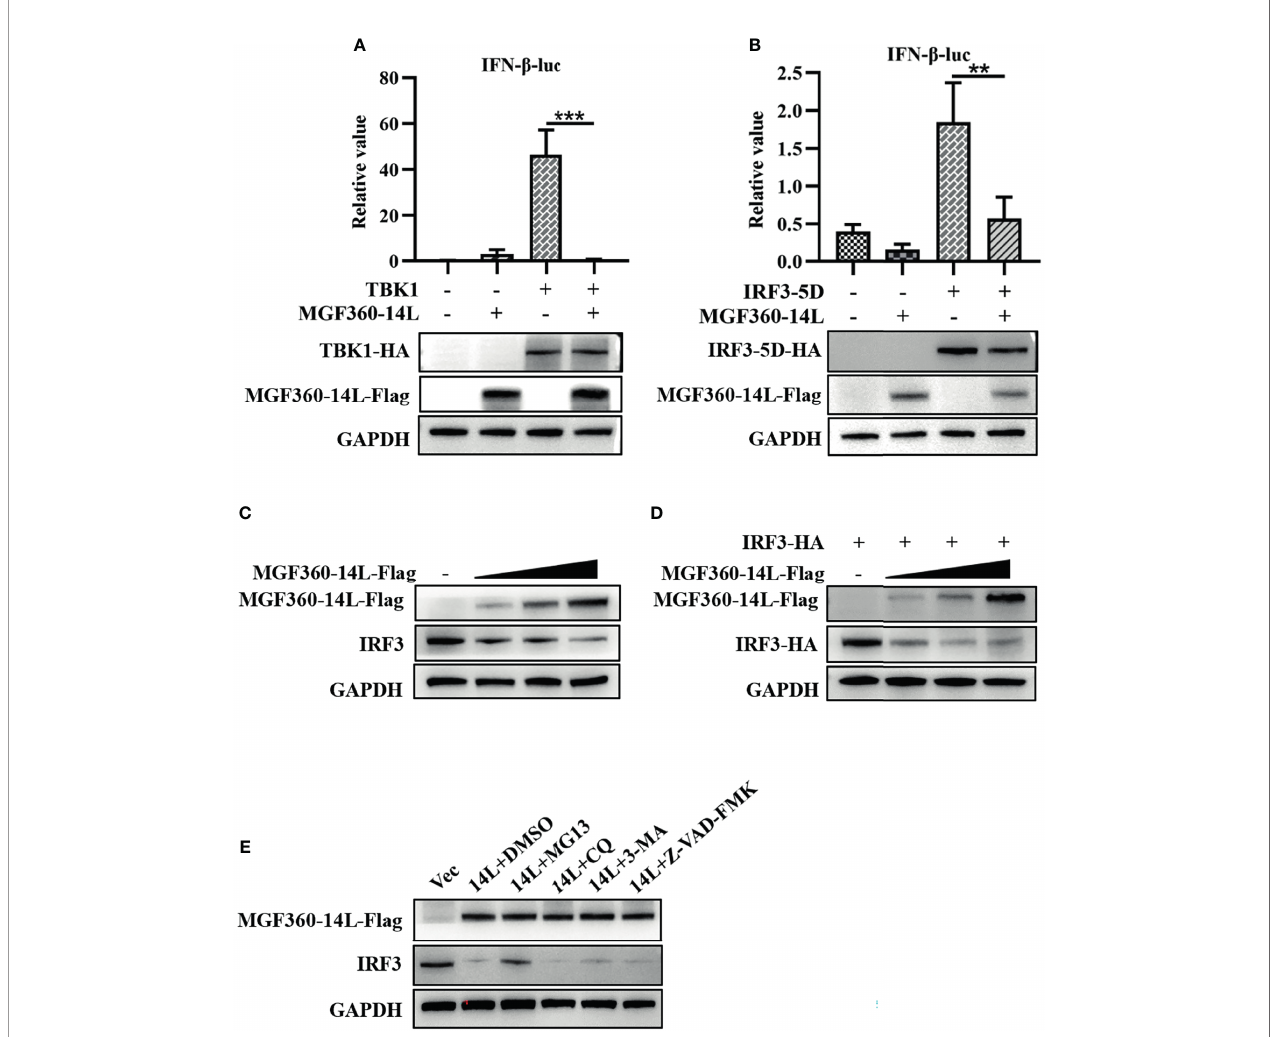
FIGURE 2 | MGF360-14L inhibits IRF3-mediated IFN- b promoter activation. (A, B) HEK293T cells were co-transfected with IFN- b -luc (20 ng), pRL-TK (2 ng), TBK1 (50 ng) or IRF3-5D (50 ng), and MGF360-14L-Flag (50 ng) or empty plasmid. At 24 h post-transfection, cells were treated and analyzed using dual-luciferase reporter assays. (C) HEK293T cells were transfected with MGF360-14L-Flag (0 ng, 200 ng, 400 ng and 600 ng) or empty vector. (D) HEK293T cells were transfected with IRF3-HA (200 ng) and MGF360-14L-Flag (0 ng, 200 ng, 400 ng, and 600 ng) or empty vector. (E) HEK293T cells transfected with MGF360-14L-eGFP and then treated with DMSO or MG132 (25 m M), CQ (50 m M), 3-MA (10 mM) and Z-VAD-FMK (20 m M) for 6 h. Expression of IRF3, IRF3-HA, TBK1-HA, IRF3-5D-HA, MGF360-14L-Flag and GAPDH were assessed by western blot analysis. Data shown are the mean ± SEM; **p < 0.001, ***p < 0.001. Representative results are from at least three independent